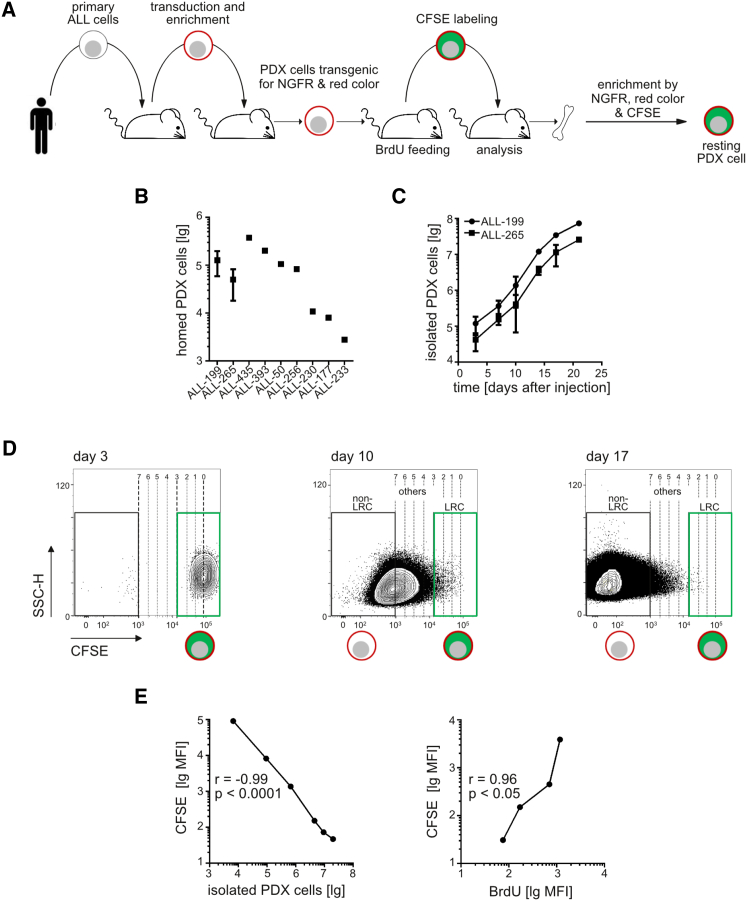
CFSE Staining Allows Reliable Monitoring of PDX ALL Growth in Mice(A) Experimental procedure of generating PDX ALL cells expressing several transgenes, staining with CFSE, and enriching rare transgenic, CFSE-stained PDX cells from mouse bone marrow.(B) Of each PDX sample, 107 triple transgenic PDX cells were injected intravenously into mice and re-isolated from the bone marrow 3 days later; each dot represents data from one mouse, except that a mean of eight mice plus SE is shown for samples ALL-199 and ALL-265.(C) 107 CFSE-stained PDX cells/mouse were injected and PDX cells were quantified in up to 11 mice per time point; shown is mean and SE.(D) Gating strategy defining LRC, non-LRC, and others. MFI of CFSE at the start of the experiment (3 days after cell injection) was divided by factor 2 to model bisections; upon no more than three bisections, cells were considered as LRC, upon more than seven bisections as non-LRC; intermediate cells were considered as others.(E) Similar experiment as in (C), except that the donor mouse was fed with BrdU in the last 7 days before cell harvesting. Each dot represents data from one mouse.See also Figure S1, Tables S1, and Table S2.